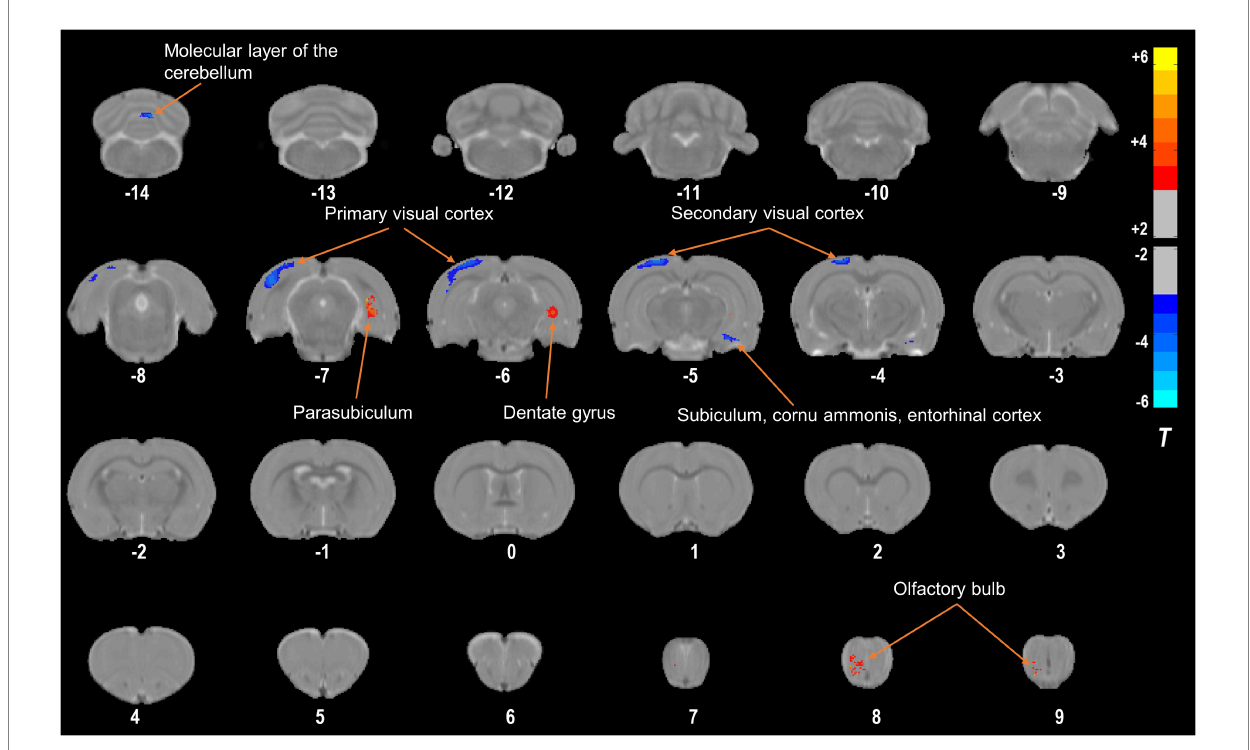
FIGURE 2 Compared with the NC group, the FDM group had altered GMVs. The regions with decreased GMVs are shown in blue, including the left primary visual cortex, left secondary visual cortex, right subiculum, right cornu ammonis, right entorhinal cortex, and bilateral molecular layer of the cerebellum. The regions with increased GMVs are shown in red, including the right dentate gyrus, parasubiculum, and olfactory bulb. NC, normal control; FDM, form- deprivation myopia; GMV, gray matter volume.